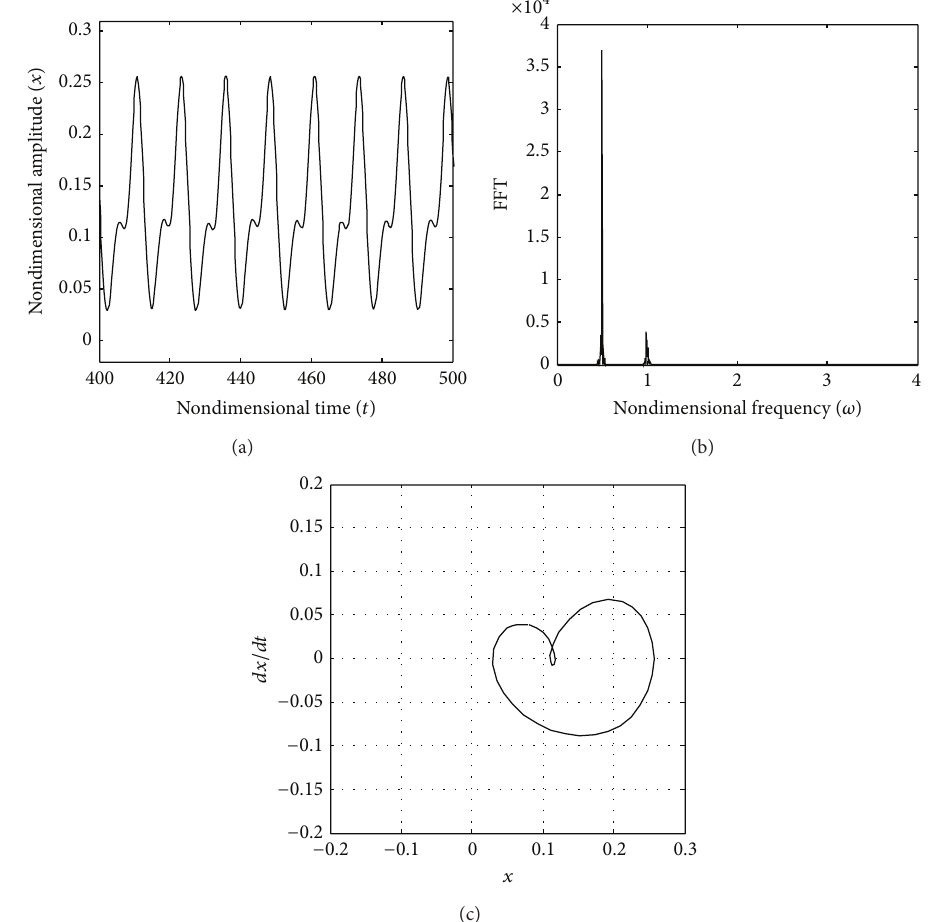
Figure 7: (a) Time history, (b) Fourier spectra, and (c) phase plane, for 𝑓 𝑝 = 0.38